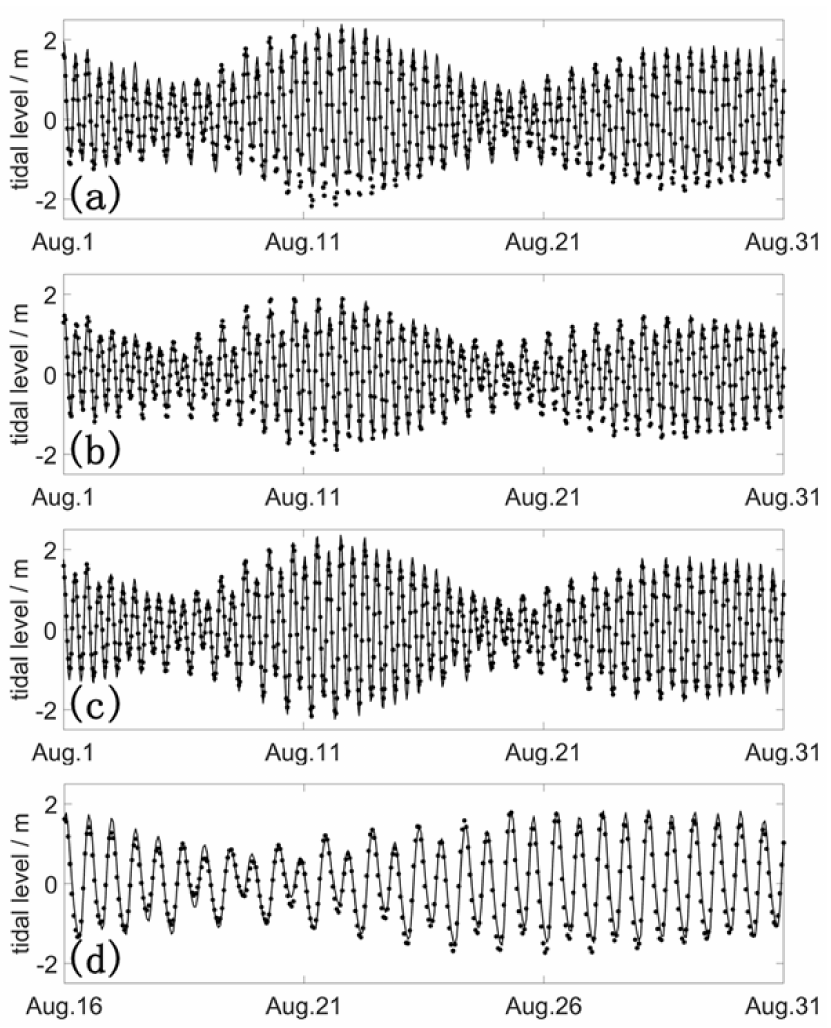
Figure 2. Tidal level comparations at ( a ) T1, ( b ) T2, ( c ) T3, and ( d ) T4. Solid lines represent the model results; dotted lines represent the observational